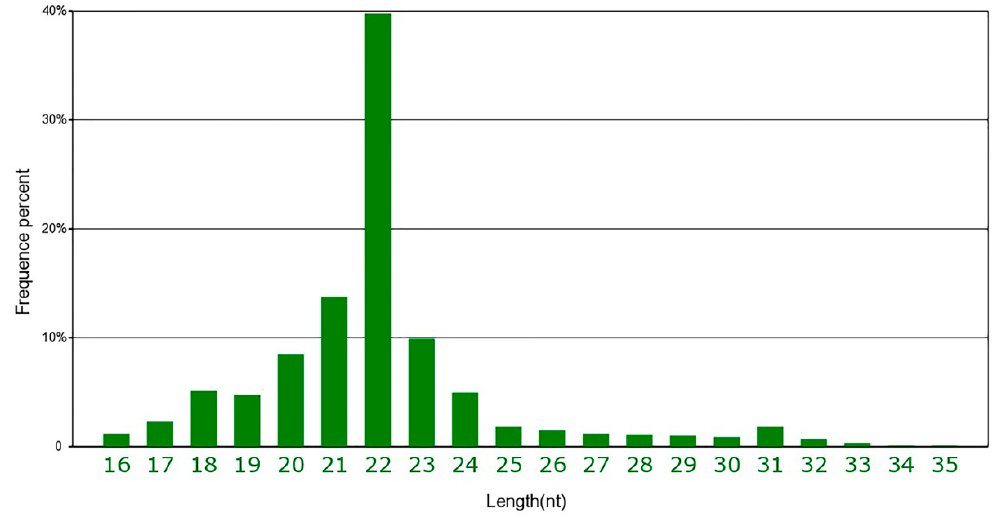
Figure 2. The distribution of small RNA reads.